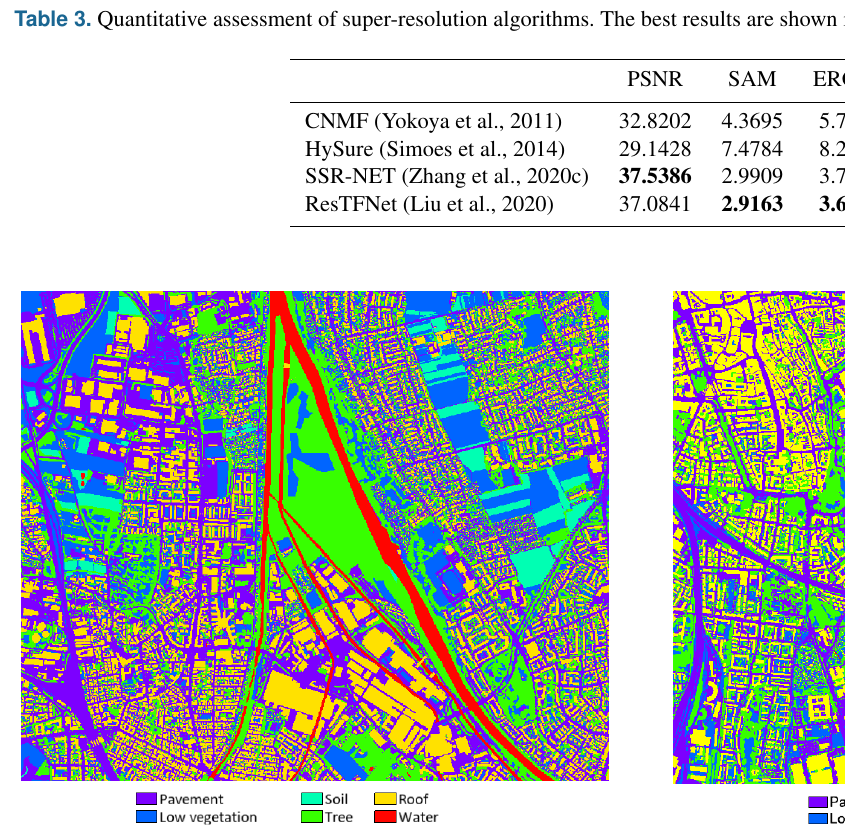
Figure 6. The manually delineated land cover composition of the sub2 region based on the DLR 3K